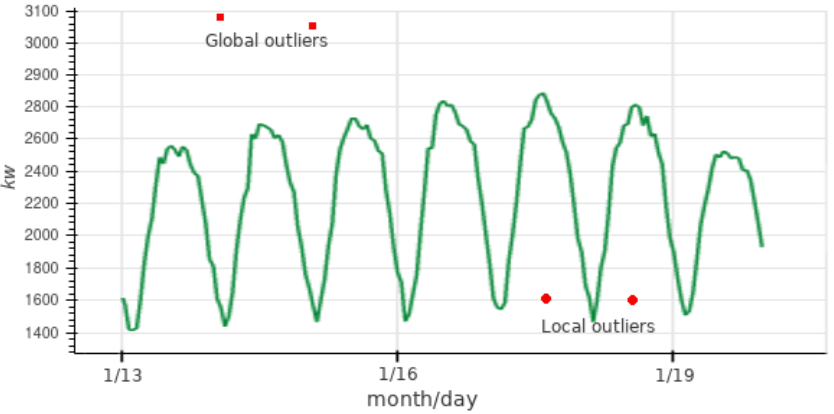
Figure 9. Global and local